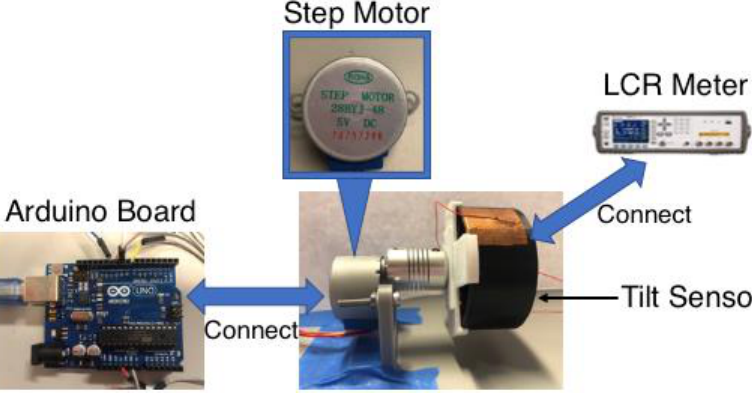
Figure 6. The tilt sensor characterization setup uses an Arduino to control a stepper motor to apply a controlled tilt to the prototype sensor. controlled tilt to the prototype